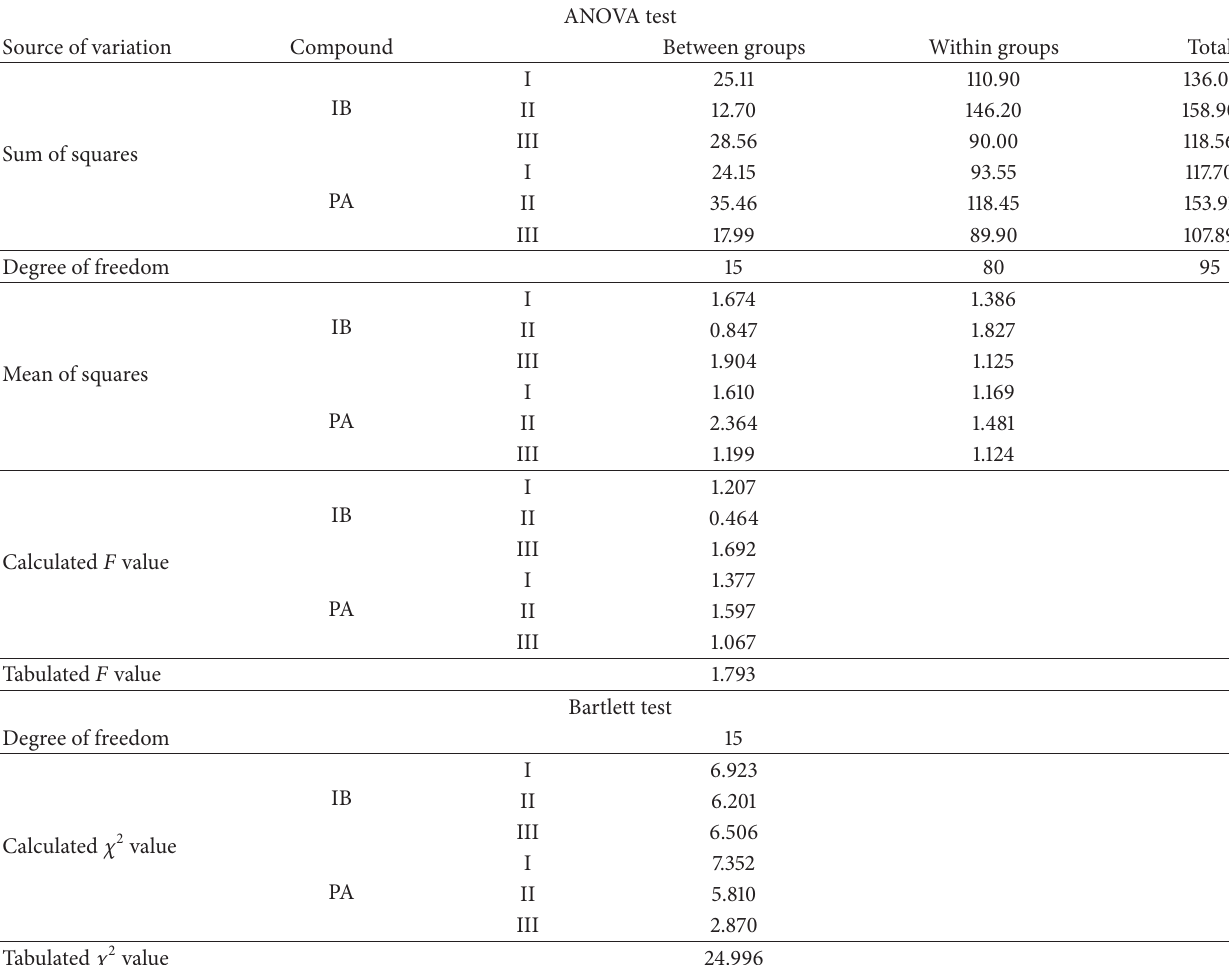
Table 3: Results of ANOVA and Bartlett tests at the significance level of 5% by applying spectrophotometric and chromatographic methods to three commercial pharmaceutical